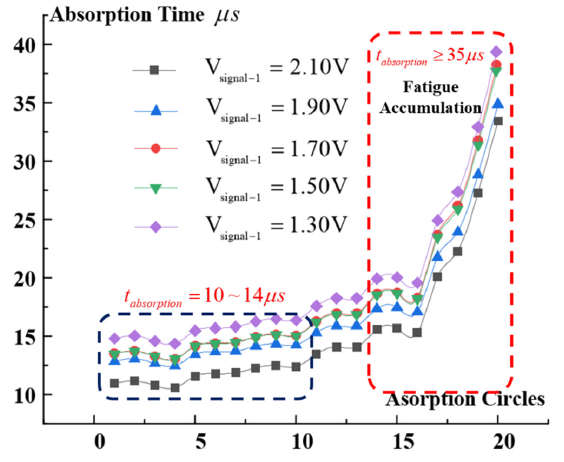
Figure 8. Absorption time changes with driving voltage and number of test cycles. Over the same number of test cycles (cycles = 1–14), the driving voltage ( V signal-1 ) of